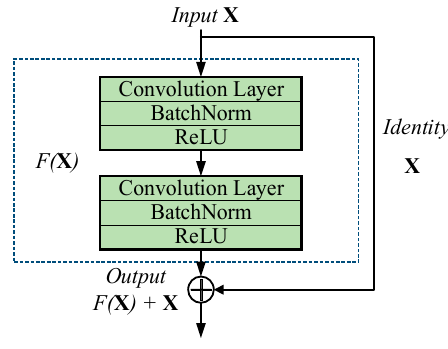
Figure 1. Residual learning block.